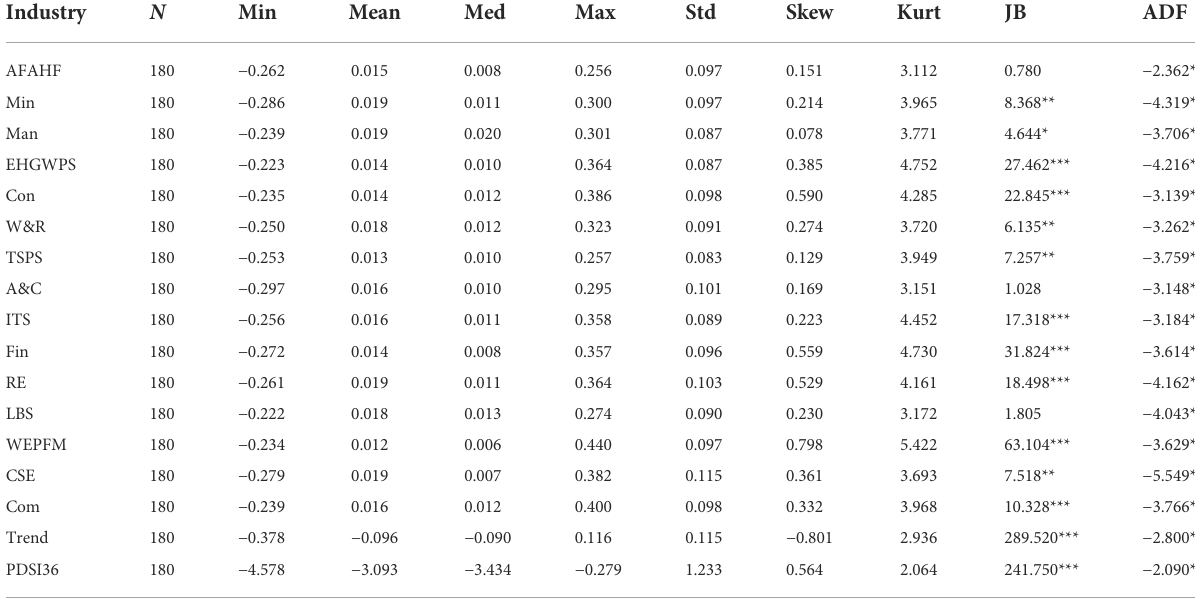
TABLE 2 Summary statistics.